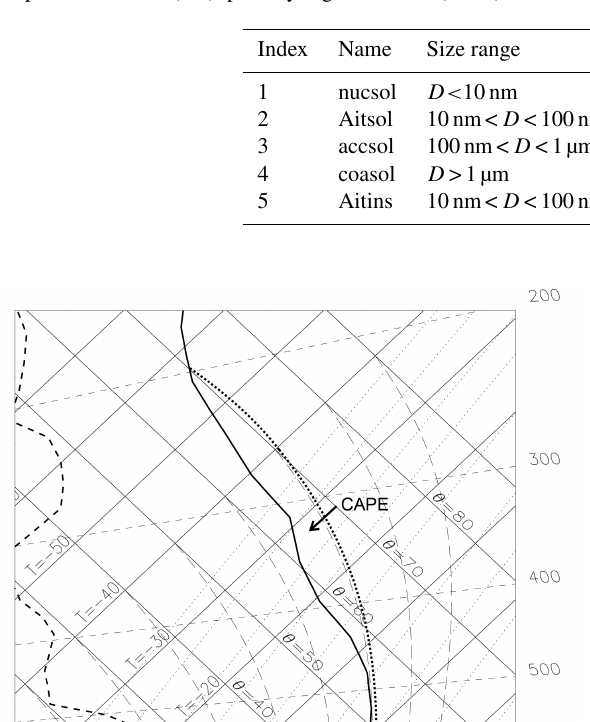
Table 1. Standard aerosol configuration for GLOMAP-mode. The size distribution is described by log-normal modes with varying geometric mean diameter D and fixed geometric standard deviation σ g . Particle number and mass are transferred between modes when D exceeds the upper limit for the mode. Names are given in function of the aerosol mode (“nuc”, “Ait”, “acc”, and “coa” stand for nucleation, Aitken, accumulation, and coarse) and their solubility properties (“sol” or “ins” mean the aerosols are soluble or insoluble). The aerosols can be composed of sulfate (SU), primary organic matter (POM), black carbon (BC), or sea salt (SS).